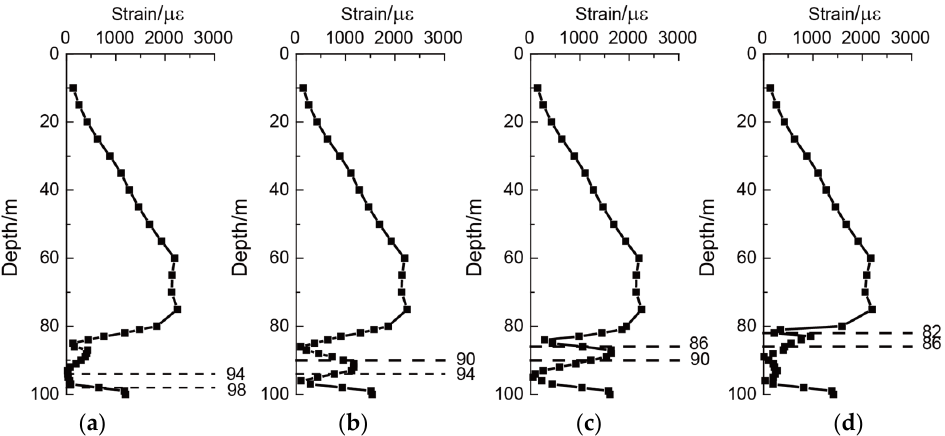
Figure 6. Results of the rock-socketed piles with different karst cave roof heights. ( a ) Height 14 m, ( b ) 10 m, ( c ) 6 m, and ( d ) 2 m.